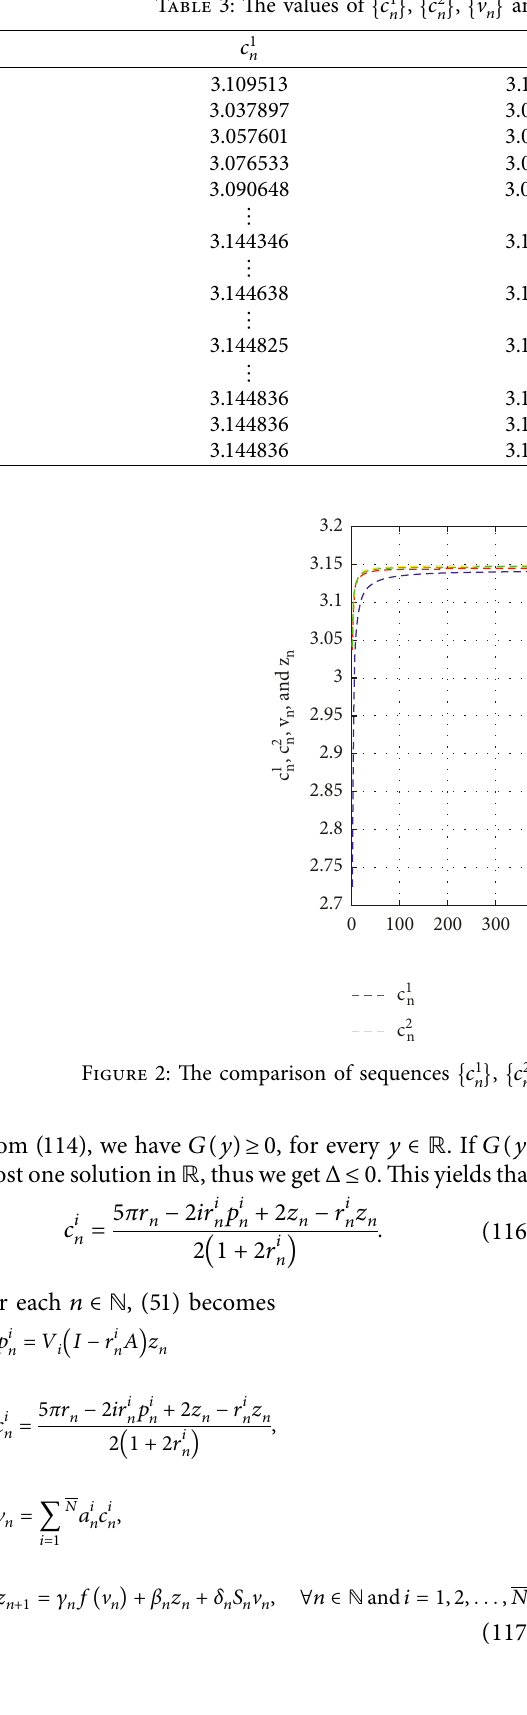
Table 3: The values of c 1